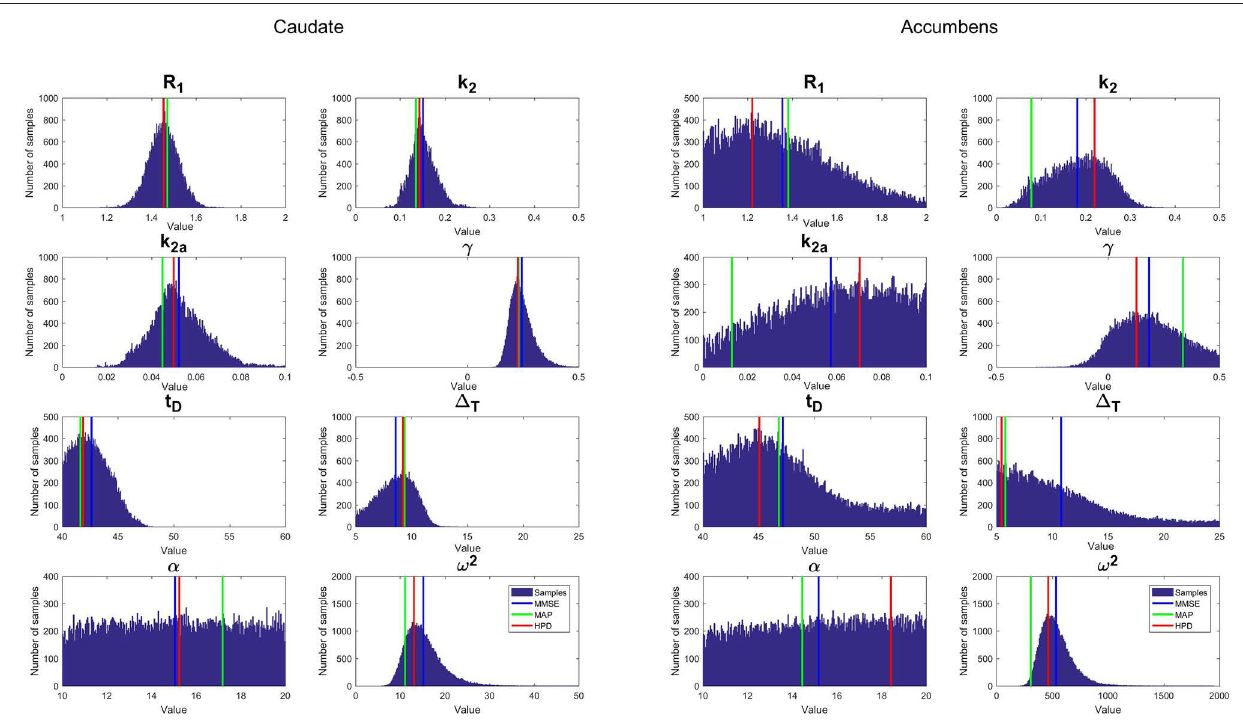
FIGURE 5 | Example of the marginal distribution estimated for each parameter with b-ntPET and for a single simulated subject at condition DR25. Vertical lines show the inferred value of each parameter according to the proposed estimator HPD (red) compared to popular estimators MMSE (blue) and MAP (green). (Left) , caudate; (Right) ,